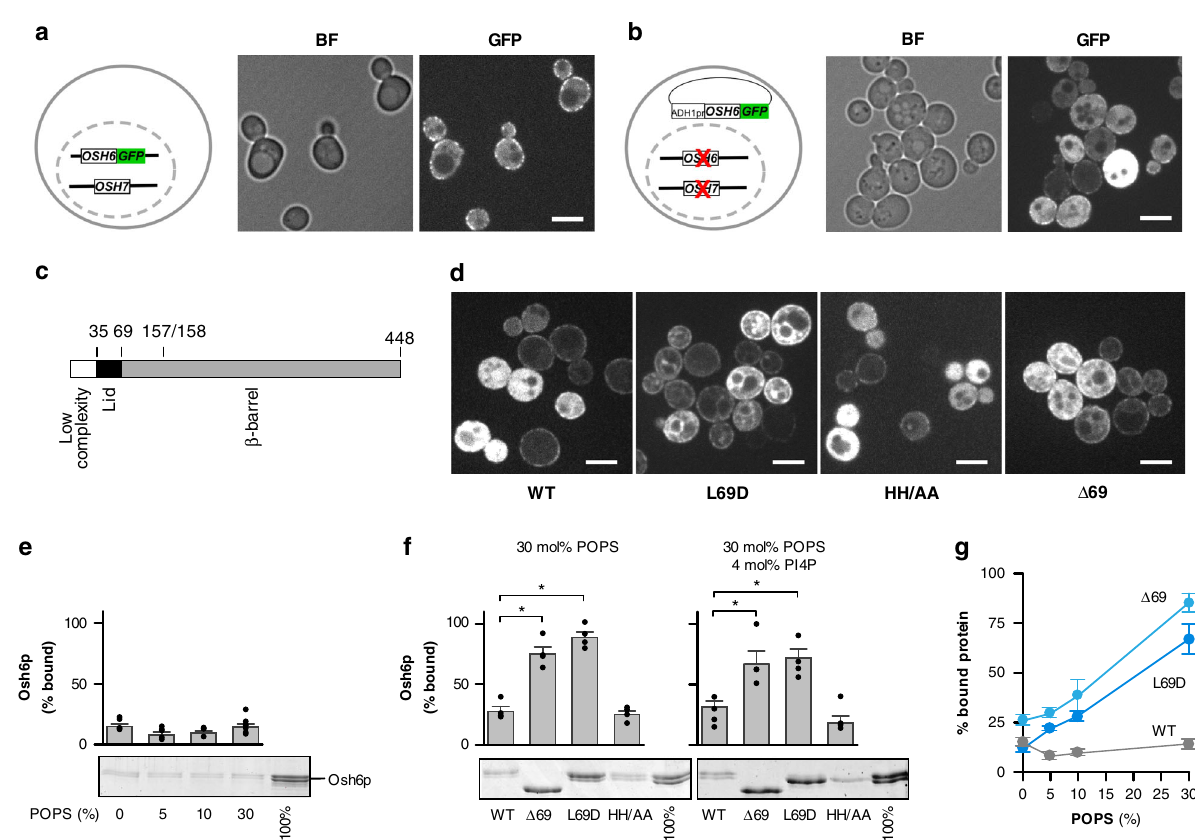
Fig. 1 Osh6p weakly binds to membranes due to its lid region. a Localization of chromosomally-tagged Osh6p-GFP in wild-type yeast, as depicted in the scheme.Bright fi eld (BF) and GFP fl uorescence images are shown. Scale bar: 5 μ m. b Localization of Osh6p-GFP, under the control of an pADH1 promoter expressed from a low-copy plasmid in osh6 Δ osh7 Δ cells, as depicted in the scheme. Level of Osh6-GFP expression varies due to variability in plasmid copy number per cell. Scale bar: 5 μ m. c Representation of the different sub-regions of Osh6p showing the position of mutations and deletions in Osh6p mutants. d Localization of Osh6p WT and mutants fused to mCherry expressed from a plasmid in osh6 Δ osh7 Δ cells as in ( b ). Scale bar: 5 μ m. e Flotation assay. Osh6p (750 nM) was incubated in HK buffer at 25 °C for 10 min with DOPC liposomes (750 µ M lipids) containing 0, 5, 10 or 30% POPS at the expense of DOPC. After centrifugation, the liposomes were recovered at the top of a sucrose cushion and analyzed by SDS-PAGE. The amount of protein recovered in the top fraction (lane 1 to 4) was quanti fi ed and the fraction of liposome-bound Osh6p was determined using the content of lane 5 (100%) as a reference. Experiments were repeated ( n = 4 – 7) using different batches of extruded liposomes. f Osh6p, Osh6p Δ 69, Osh6p(L69D) or Osh6p(HH/AA) was added to DOPC liposomes doped with 30% POPS or to DOPC/POPS/diC16:0-PI4P (66/30/4 mol/mol) liposomes ( n = 4, * P < 0.05, Mann – Whitney test). g Percentage of membrane-bound Osh6p, Osh6p Δ 69 or Osh6p(L69D) as a function of the density of POPS in liposomes ( n = 4 – 7 for Osh6p WT, n